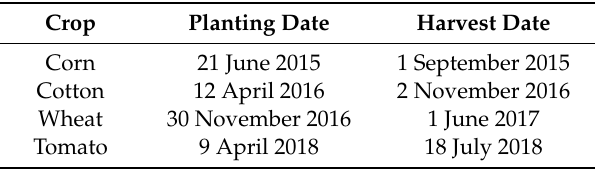
Table 3. Crop rotation in the experimental